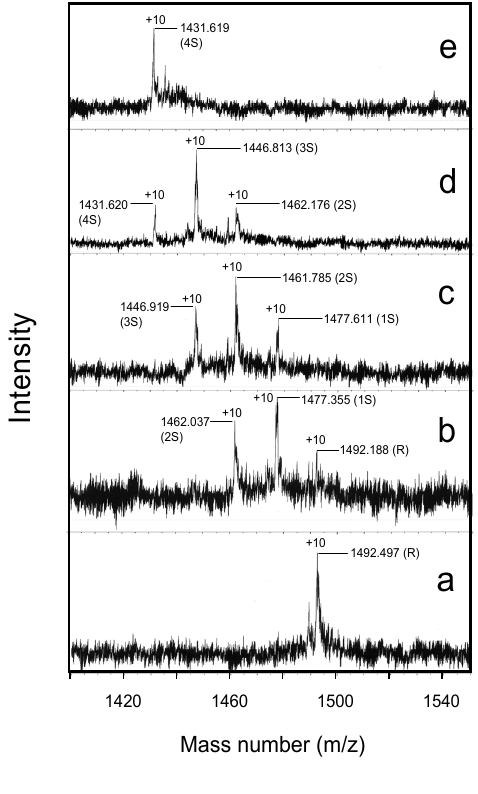
Figure 2. Expanded ESI(+) mass spectra of the sample solutions (with AEMTS blocking) obtained from the short-term oxidative folding of HEL at 25 °C and pH 8.0 in the presence of 4 M urea. ( a ) Reduced HEL ([R] = 103 µM); ( b ) 1 eq DHS ox ; ( c ) 2 eq DHS ox ; 0 ( d ) 3 eq DHS ox ; and ( e ) 4 eq DHS ox were reacted with R for 1